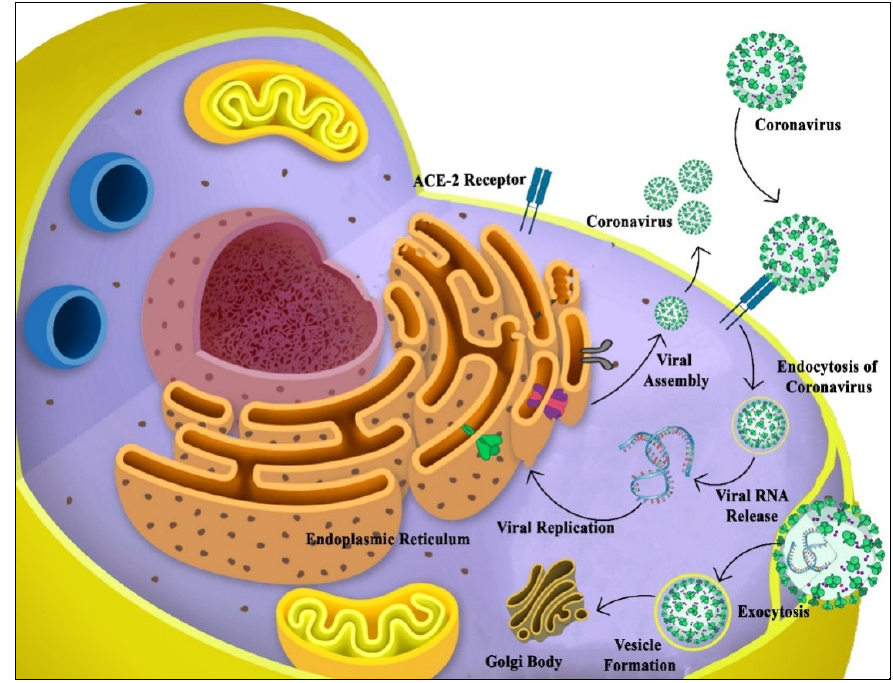
Figure 2. Diagram representing the mechanism by which coronavirus infiltrates the human system followed by its replication and spread. followed by its replication and